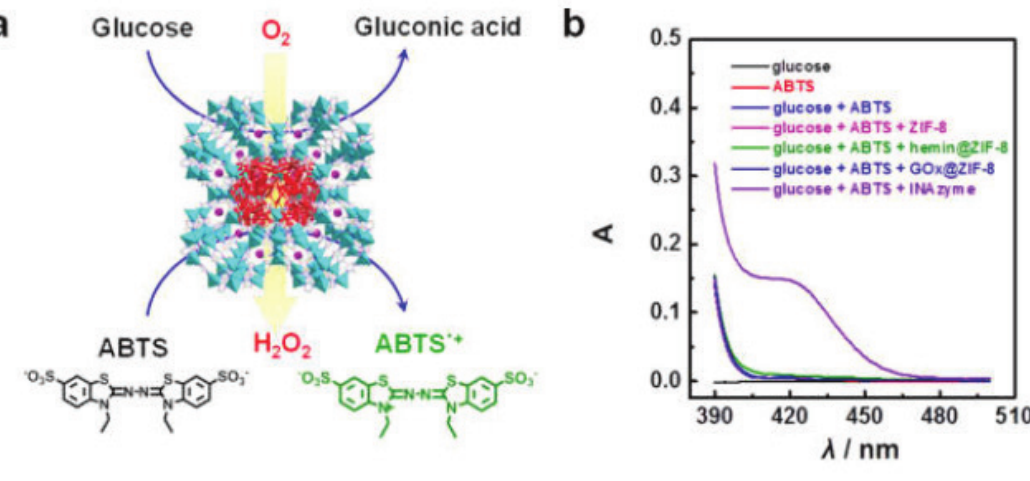
Figure 18: (a) Schematic illustration of GOx/haemin@ZIF-8 (INAzyme) cascade oxidation of glucose and ABTS to produce ABTS ●+ ; (b) Activity of GOx/haemin@ZIF-8 (INAzyme) and other components of the crystal system in 0.10 M Tris-HCl buffer (pH 7.0), respectively [127]. Reprinted with permission from Ref. [127]. Copyright © 2016, American Chemical Society.